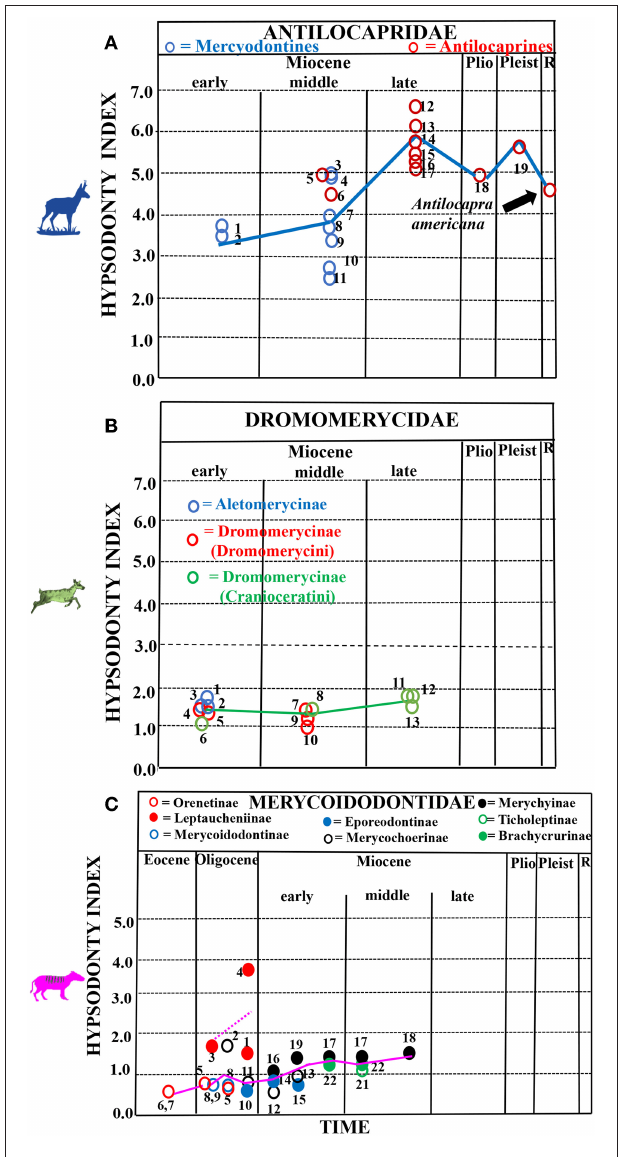
FIGURE 3 | Hypsodonty indices of fossil pronghorns, dromomerycids and oreodonts through time. (A) North American fossil pronghorns through time. Key to taxa: blue circles = merycodontines (1 = Paracosoryx wilsoni, 2 = Paracosoryx alticornis, 3 = Cosoryx furcatus, 4 = Cosoryx cerroensis , 7 = Meryceros nenzelensis, 8 = Ramoceros ramosus, 9 = Ramoceros sp., 10 = Merycodus sabulonis , 11 = Merriamoceras coronatus ); red circles = antilocaprines 12 = Hexabelomeryx sp., 13 = Ilingoceros sp., 14 = Texoceros guymonensis, 15 = Osbornoceras osborni , 16 = Plioceras dehlini , 17 = Hexabelomeryx sp., 18 = Capromeryx sp., 19 = Stockoceros sp., 20 = Antilocapra americana (Recent)]. Blue solid line = hypsodonty index trendline. Unpublished fossil data from Christine Janis; Recent data from Janis (1988). (B) Hypsodonty indices of North American fossil dromomerycids through time (Unpublished fossil data from Christine Janis). Key to taxa: blue circles = Aletomerycinae (1 = Aletomeryx marslandensis , 2 = Aletomeryx scotti, 3 = Sinclairomeryx riparius ); red circles = Dromomerycinae (Dromomerycini) (4 = Subdromomeryx scotti, 5 = Barbouromeryx trigonocorneus, 7 = Dromomeryx whitfordi, 9 = Rakomeryx sinclairi, 10 = Drepanomeryx sp.); green circles = Dromomerycinae